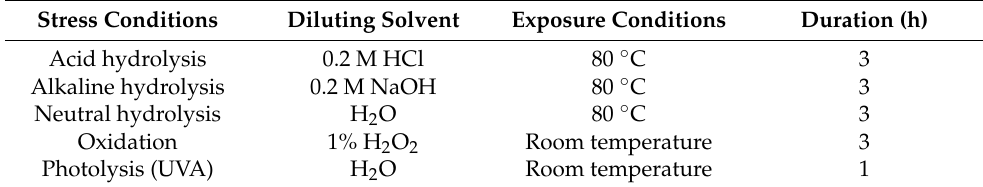
Table 2. Stress conditions applied to maraviroc